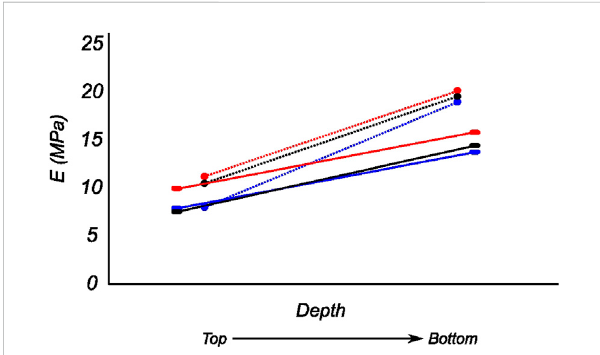
FIGURE 12 Computed biaxial elastic modulus of all meniscus samples showing regional and depth-wise variation. The circumferential and radial moduliare shownas dottedand solidlinesrespectively. Regions anterior (red), middle (blue), and posterior (black) are presented